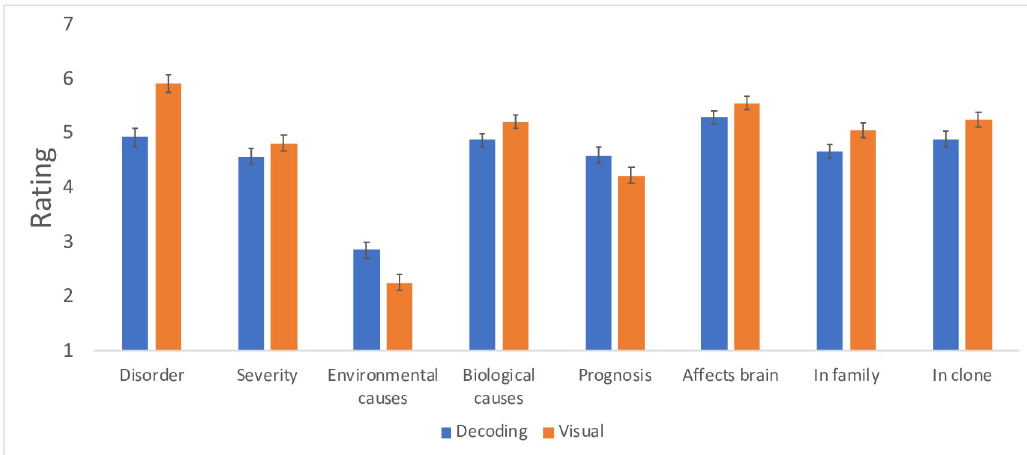
Fig 6. The perception of reading disorders associated with visual and decoding